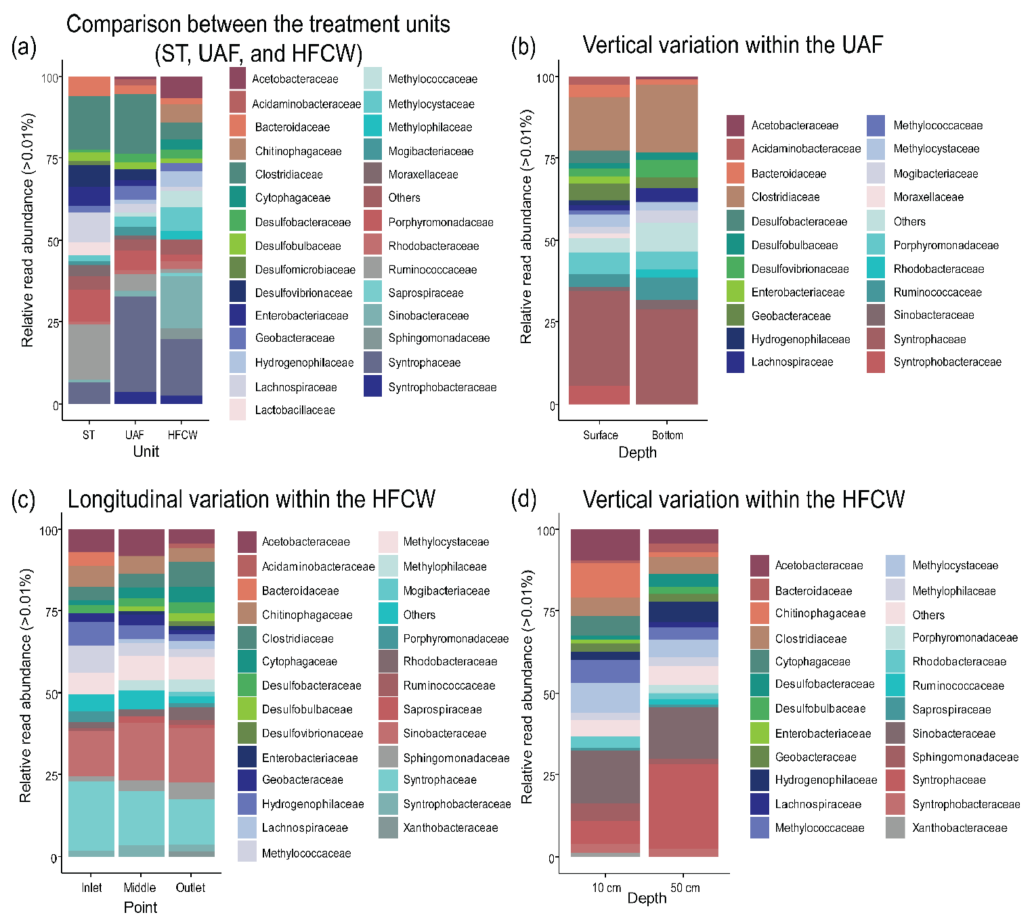
Figure 7. Organic matter degrading families ( a ) Comparison between the treatment units (ST, UAF, and HFCW), ( b ) Vertical variation within the UAF, ( c ) Longitudinal variation within the HFCW, and ( d ) Vertical variation within the